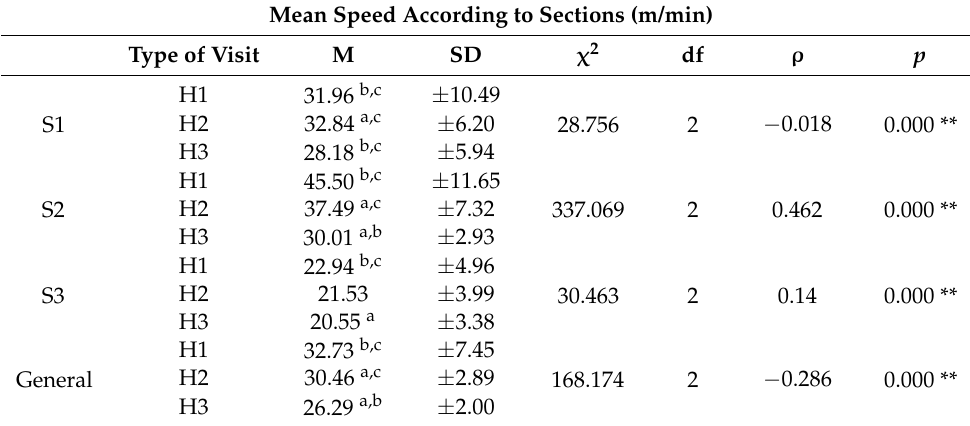
Table 5. Mean travel speed utilized to hike each of the sectors that divide the CR trail.